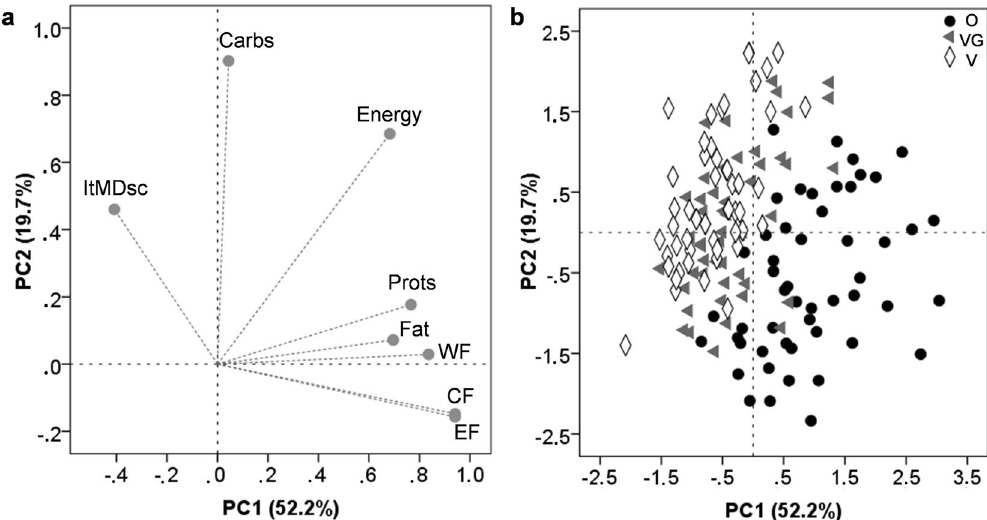
Figure 2. Loading plot ( a ) and score plot ( b ) obtained from the PCA with varimax of the energy and nutrient intakes, adherence to the Mediterranean dietary pattern, and environmental impact indicators for each diet group. ItMDsc, Italian Mediterranean Diet score; Energy, total energy; Carbs, total carbohydrates; Fat, total fat; Prots, total proteins; and CF, WF, and EF for carbon, water, and ecological footprint, respectively. O, omnivores; VG, ovo-lacto-vegetarians; V,